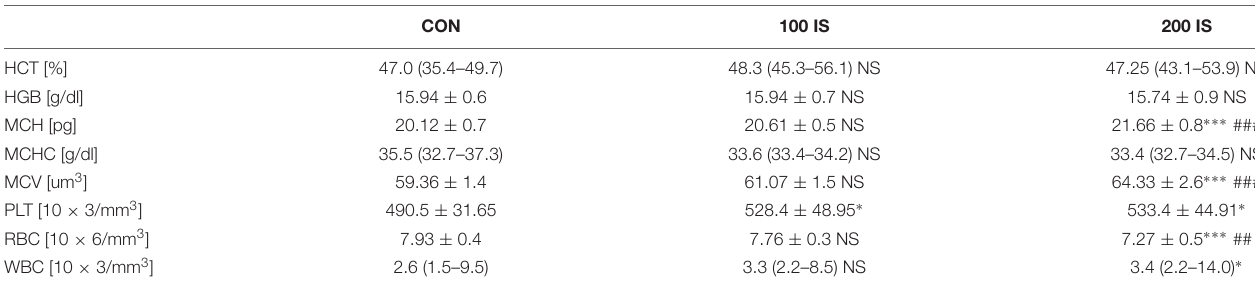
Data are shown as the mean ± SD or median (full range) depending on their distribution. CON, control group; 100 IS, group receiving IS in the dose of 100 mg/kg b.w./day; 200 IS, group receiving IS in the dose of 200 mg/kg b.w./day; HCT,